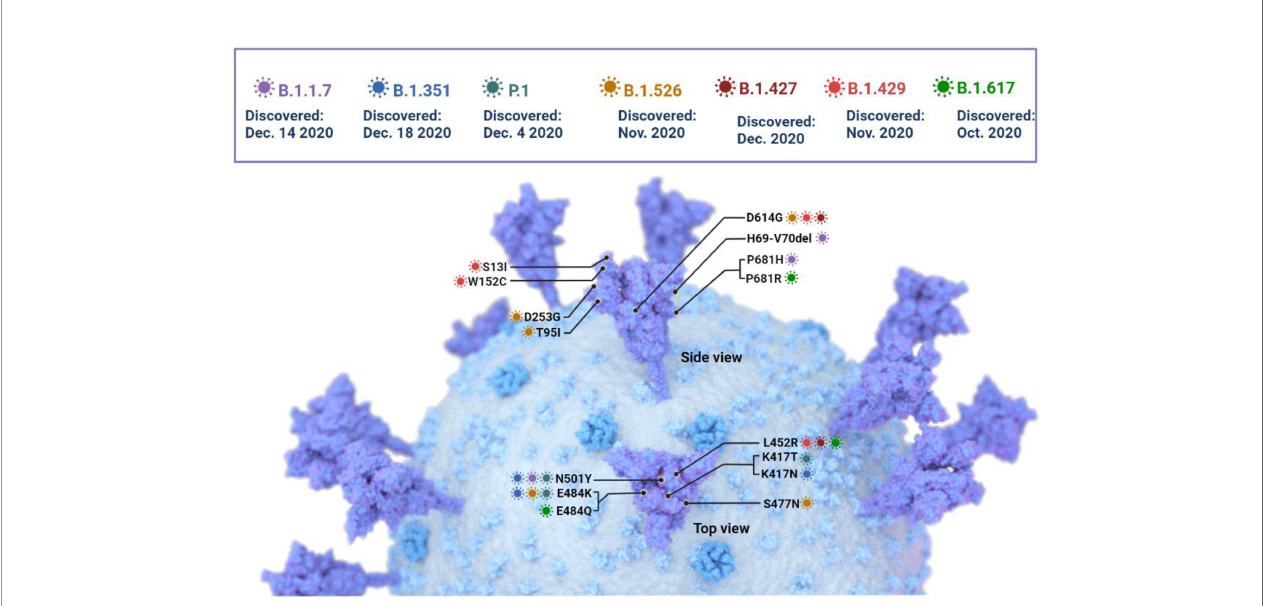
FIGURE 4 | The SARS -CoV-2 Variants of concern: Key mutations in the spike protein are shown, but mutations in other areas of the genome have been identi fi ed and are currently under